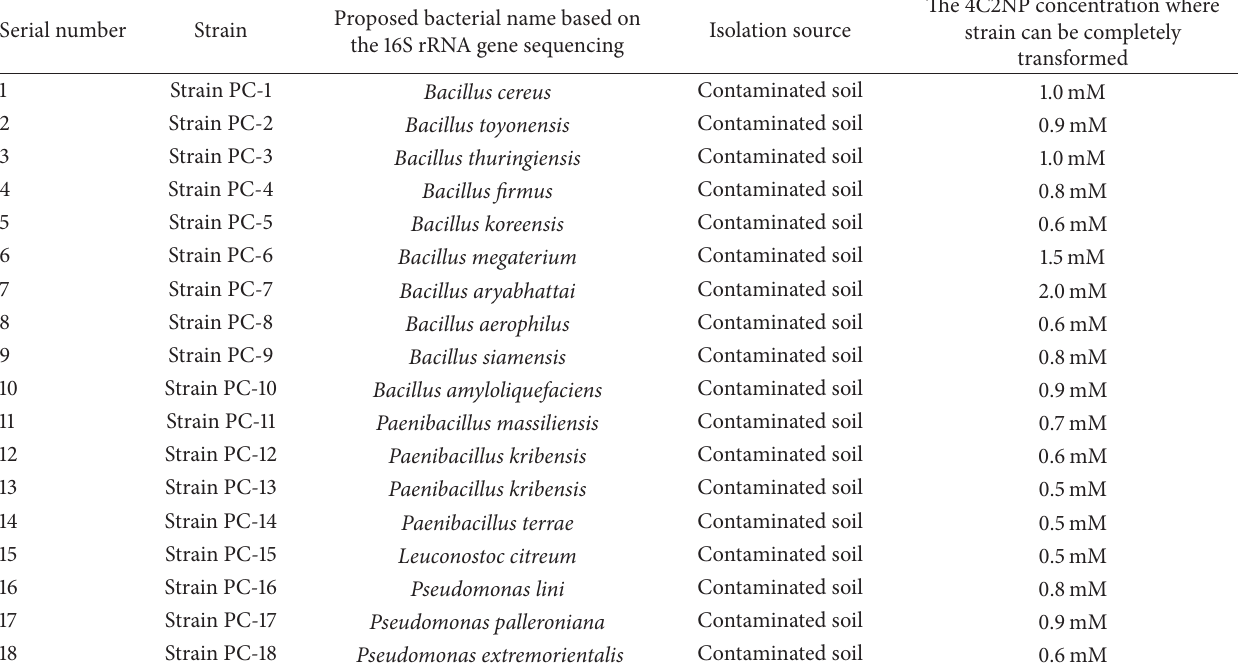
Table 1: Showing degradation of various concentrations of 4-chloro-2-nitrophenol by the eighteen